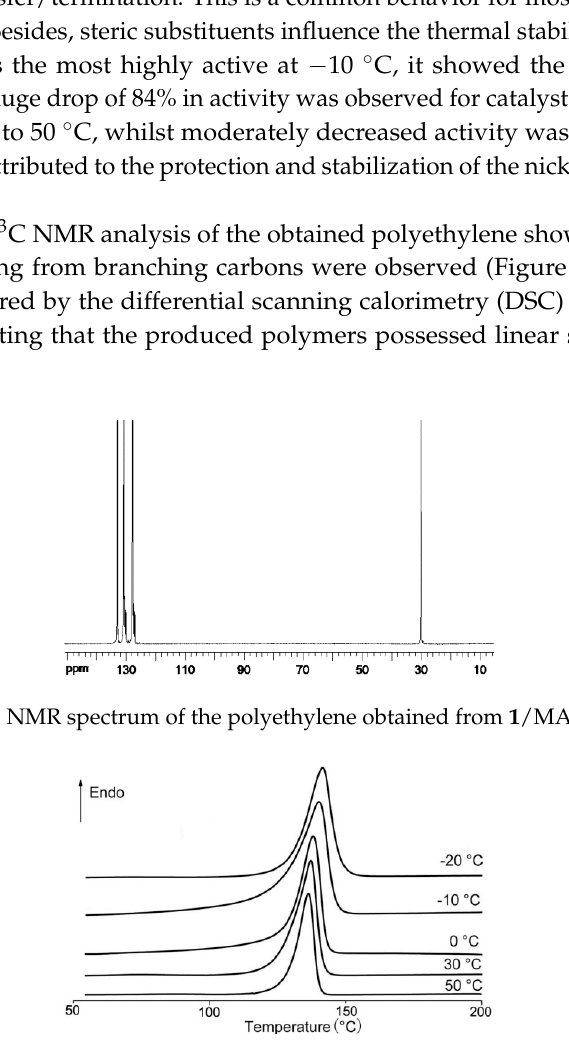
Figure 3. DSC curves of polyethylenes obtained by 1 /MAO at different temperatures (entries 1–5 in Table 1).